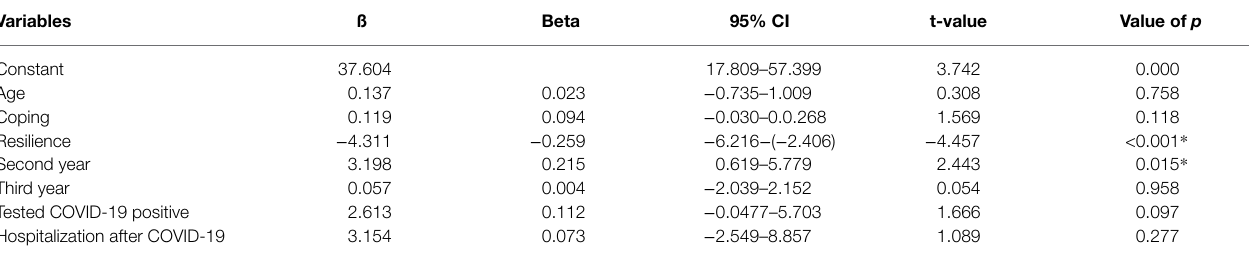
TABLE 4 | Multiple linear regression on factors associated with pandemic fatigue ( n = 256).